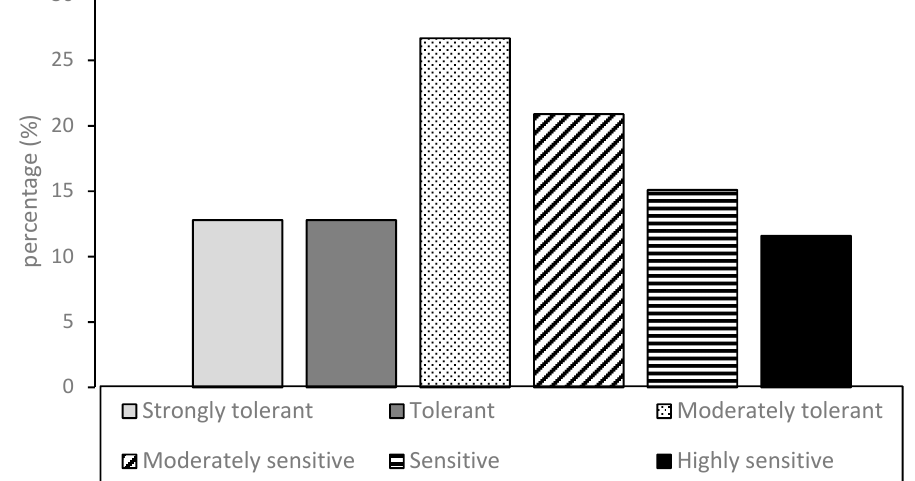
Figure 4. Percentage distribution of mango cultivars having a different sensitivity/tolerance response to anthracnose leaf infections caused by C. asianum in the Brazilian Mango Germplasm Collection at the Sementeira Farm, Universidade Federal de Viçosa.